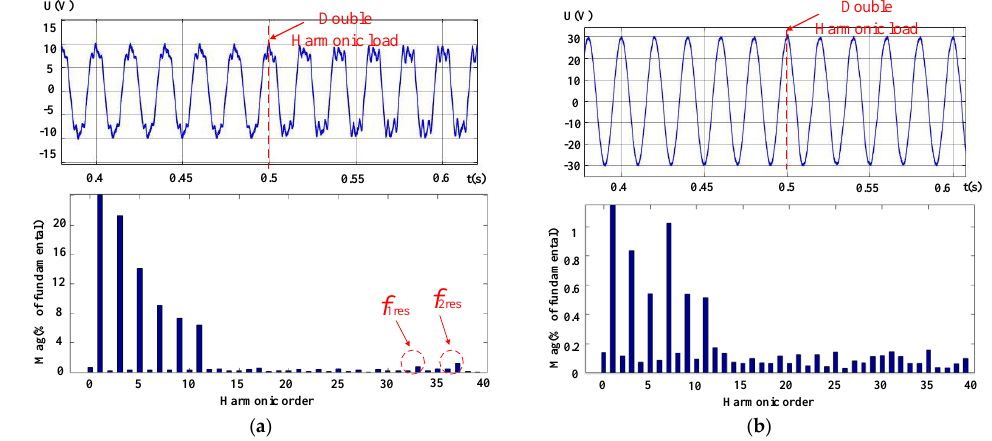
Figure 22. Output current of HCGI, grid current and them THD analysis. ( a ) Output current of HCGI and its THD after t = 0.5 s (fundamental component = 9.5151 A, THD = 31.43%); ( b ) Grid current and its THD after t = 0.5 s (fundamental component = 29.462 A, THD = 2.87%).